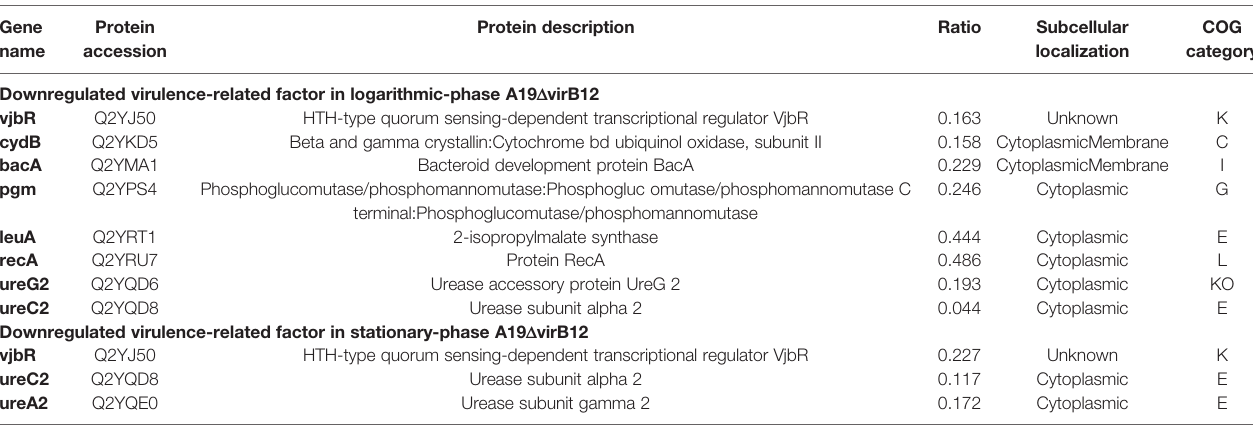
TABLE 2 | Downregulated virulence-regulated proteins in A19 D